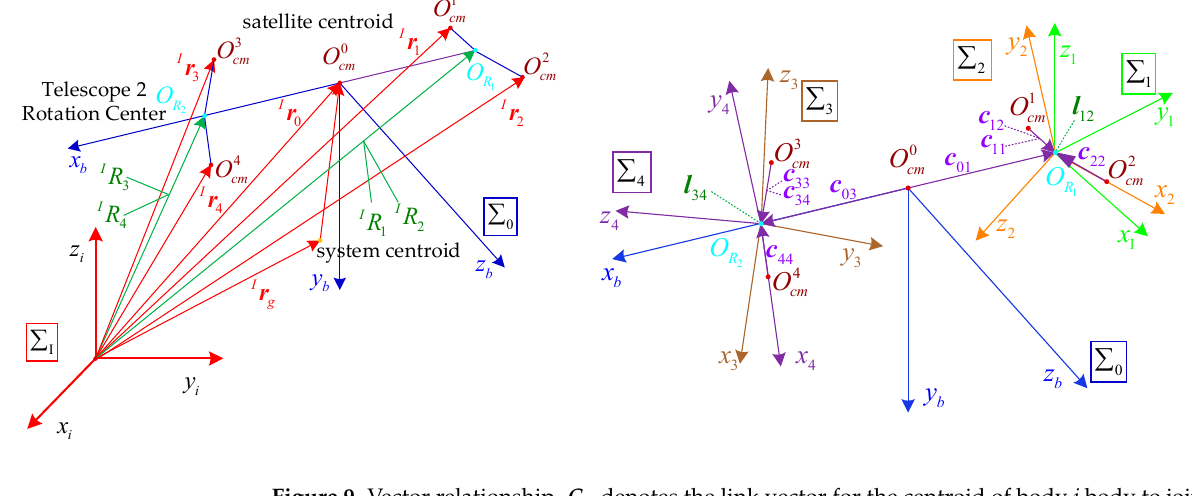
Figure 9. Vector relationship. C ij denotes the link vector for the centroid of body i body to joint j , l ij denotes the link vector from joint i to joint j , l ij = c ij − c ii , O i cm denotes the centroid of body i , O R denotes the rotation center of telescope 1, O R